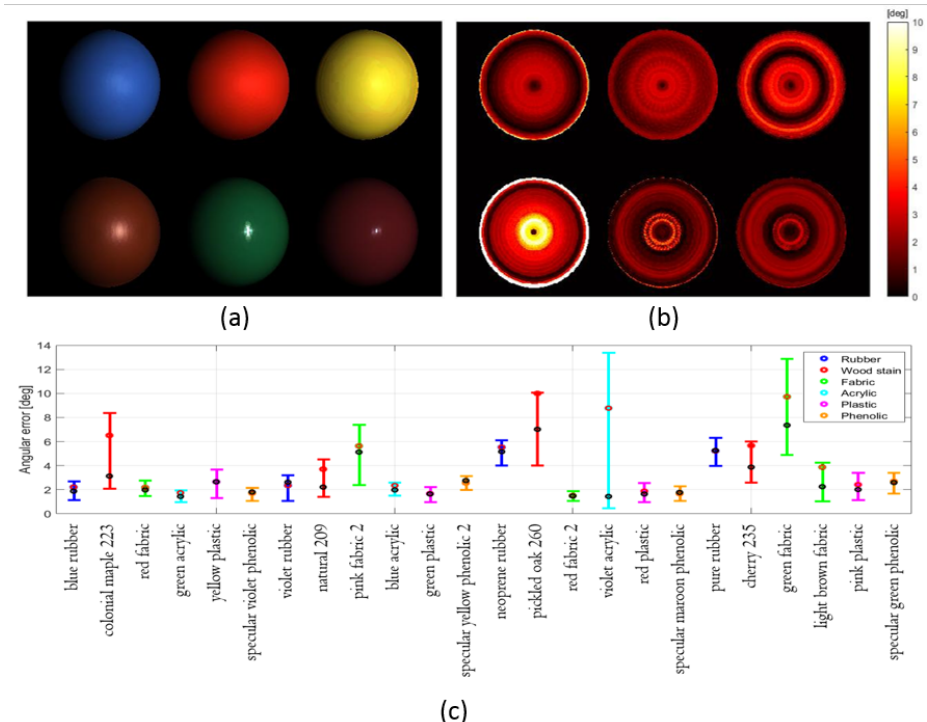
Figure 5. ( a ) Image irradiance for the first six material BRDFs under the first illuminant; ( b ) Angular error of surface orientation estimation for the first six material BRDFs; ( c ) Angular error of surface orientation for the twenty-four dielectric materals.